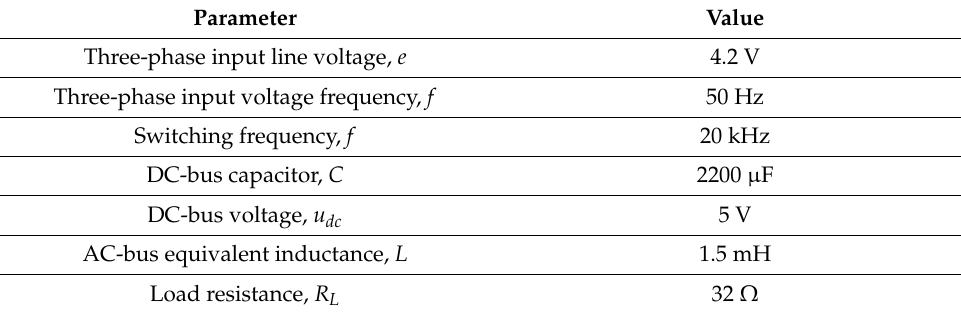
Figure 5. Simulation model of rectifier module. Table 1. Simulation circuit